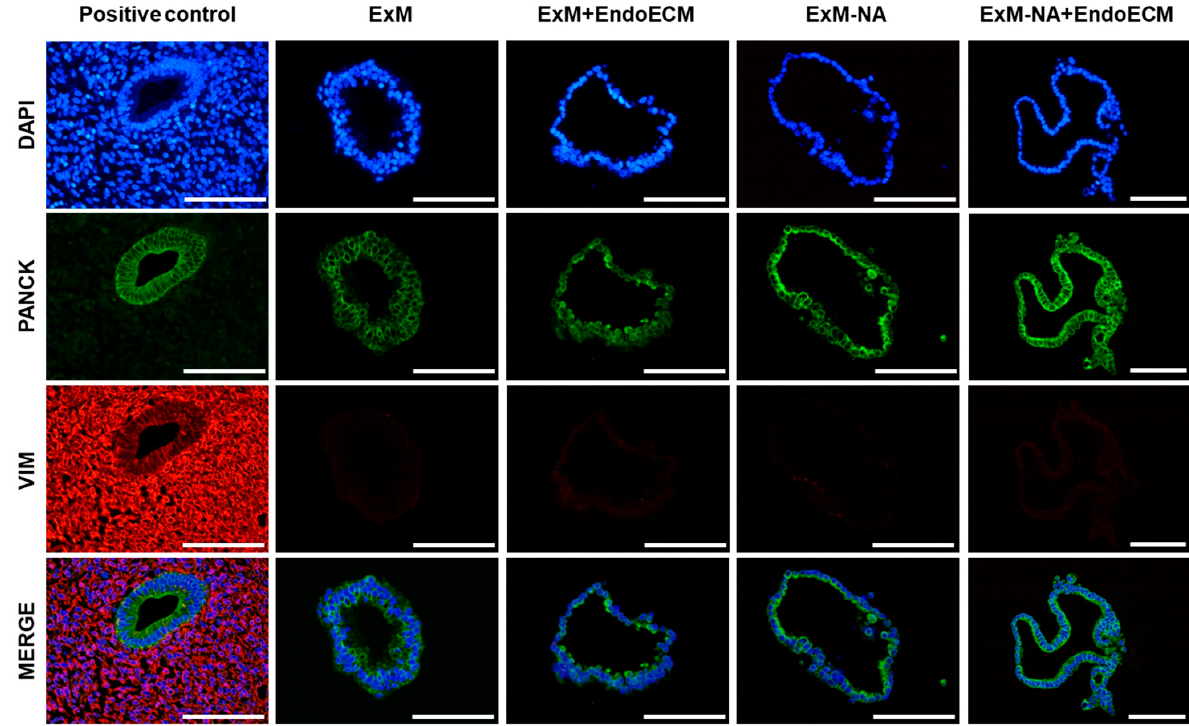
Figure 3. Characterization of epithelial phenotype in human endometrial organoid by immunofluorescence staining. Epithelial (pan-cytokeratin) and stromal (vimentin) marker expressions in human endometrium and organoids cultured in the four different experimental conditions: ExM, ExM+EndoECM, ExM-NA, and ExM-NA+EndoECM. Cell’s nuclei stained with DAPI. Scale bars are 100 μ m.